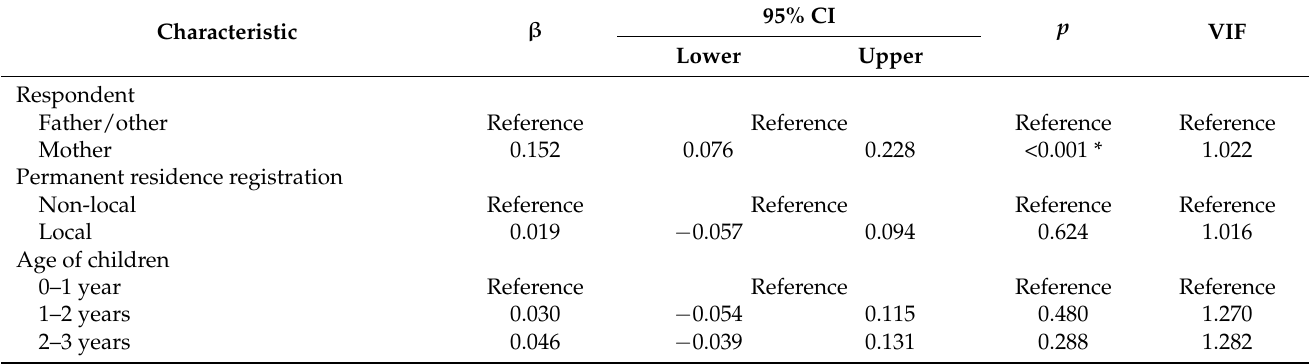
Table 7. Multiple linear regression of parental health